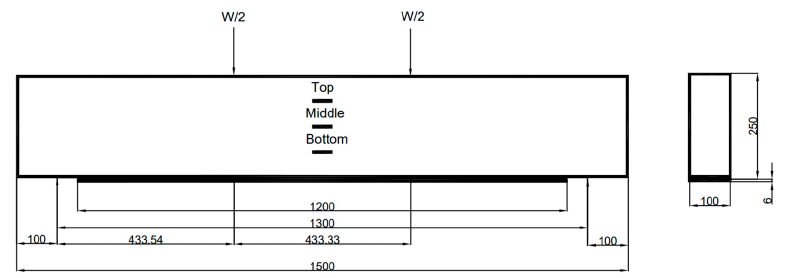
Figure 2. Pictorial representation of beam with smart mortar layer.